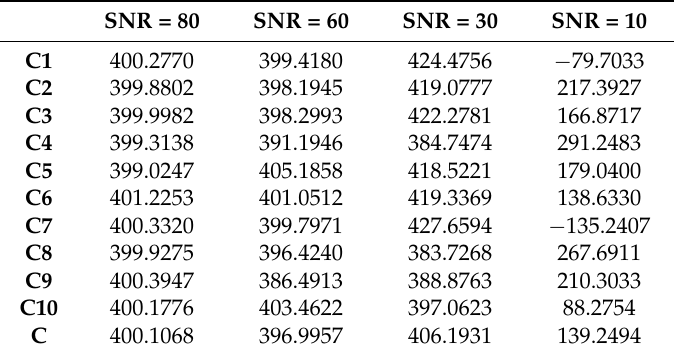
Table 6. The inversion results of different SNRs by MW-DIAL (unit: ppm).